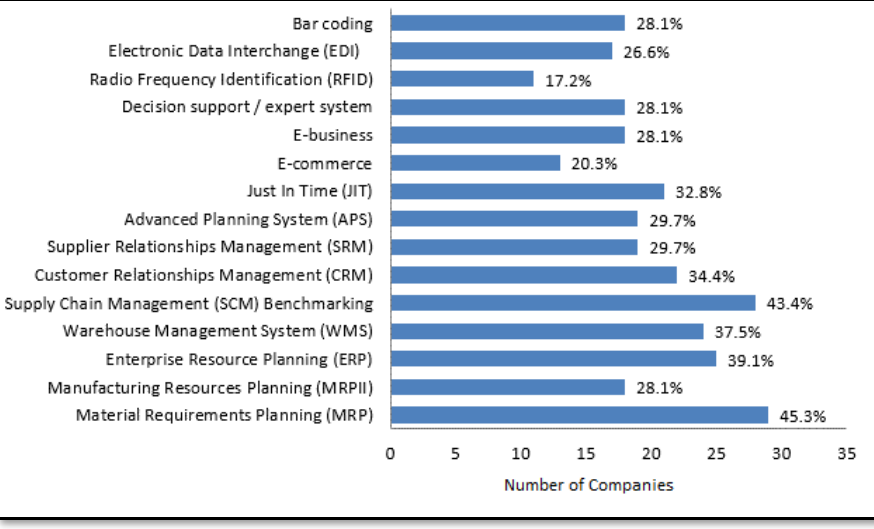
Figure 9. What SCMIS companies will implement within the next two years